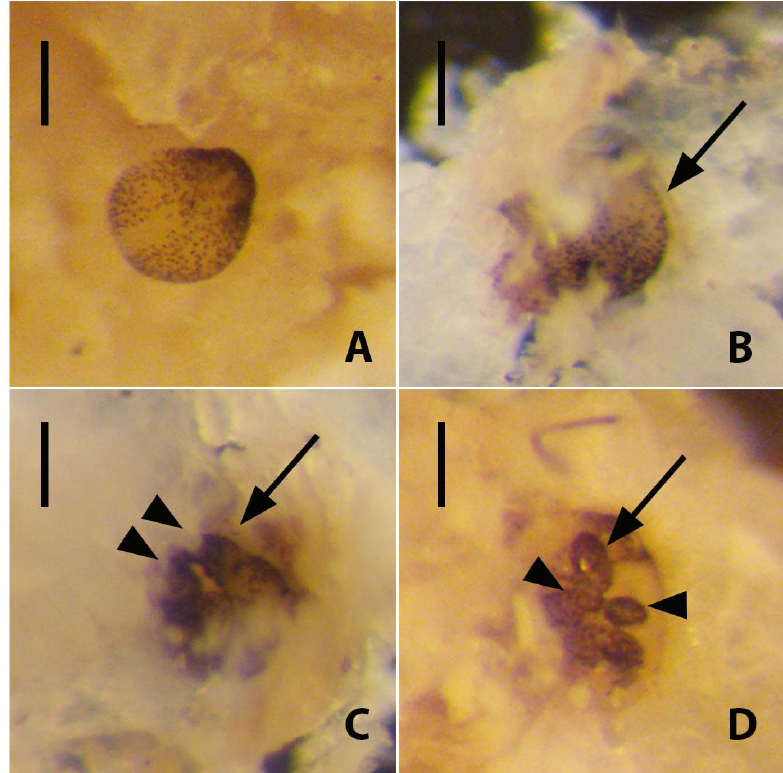
Figure 6. Rhabdopleura recondita larval development on bryozoan zoarium fragments. ( A ) A larva with the anterior end up. ( B ) The larva started secreting a dome (arrow). ( C ) After 29 days from settlement, metamorphosis began. The arm buds (arrowheads) are visible beyond the dome (arrow). ( D ) At 37 days post-settlement, the zooid is tripartite, with arms lacking tentacles (arrowheads), and has pierced the dome (arrow) to form a creeping tube. Scale bars 50 µm.